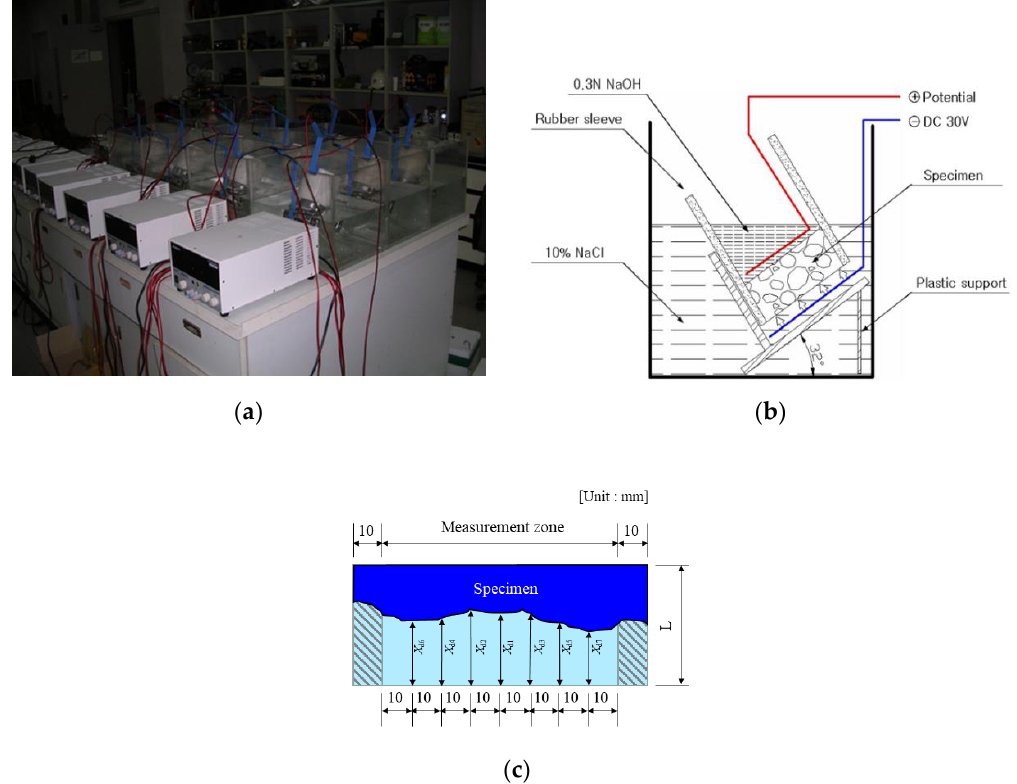
Figure 5. Test method of chloride ion diffusion coefficient. ( a ) experimental equipment; ( b ) test method; ( c ) measurement zone.